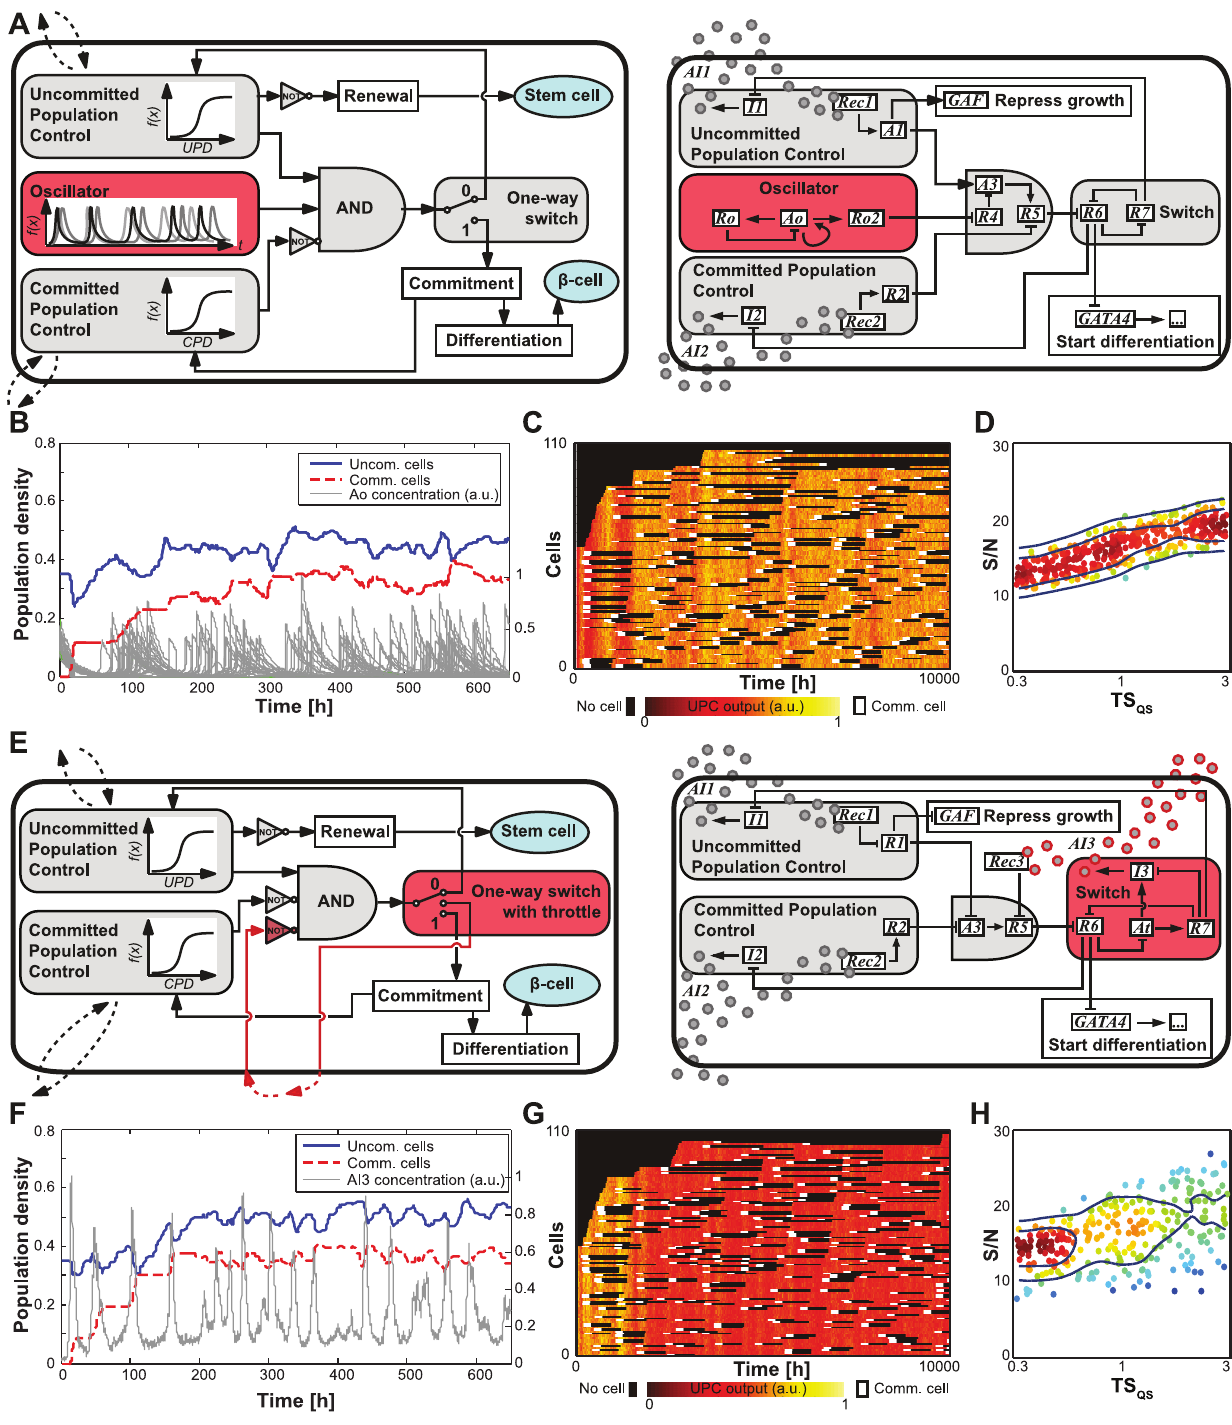
Figure 4. Systems 3 and 4. (A) Circuit diagram for System 3: in addition to System 2 modules, the AND gate integrates the output of the oscillator (red module) that allows commitment only when peaking. (B) Time trajectories for a simulation starting with a small stem cell population. The oscillator activator ( Ao ) is plotted for some representative stem cells (right axis, a.u.). (C) Individual rows track the single-cell UPC module output ( A 1 , shown as a heat map) in uncommitted cells within a population. White signifies single-cell commitment, followed by black ‘‘null space’’ that is filled by newly divided uncommitted cells. Due to the oscillator, only a fraction of the cells commit when the A 1 concentration is high. (D) Overall system performance, S/N, as a function of the module time-scale for cell communication, TS QS . Several hundred different sets of time-scales were tested, with all time-scale parameters simultaneously varied. Each point represents an individual set of time-scales. Color and contour lines indicate point density. (E) Circuit diagram for System 4: a throttle mechanism (red module) activates during a cell’s commitment and represses commitment in its neighbors. (F–G) Time trajectories for a simulation starting with a small stem cell population, where B shows the average throttle signaling component ( AI 3 ) in the external medium (right axis, a.u.) over time. (H) S/N as a function of the module time-scale for cell communication, TS QS